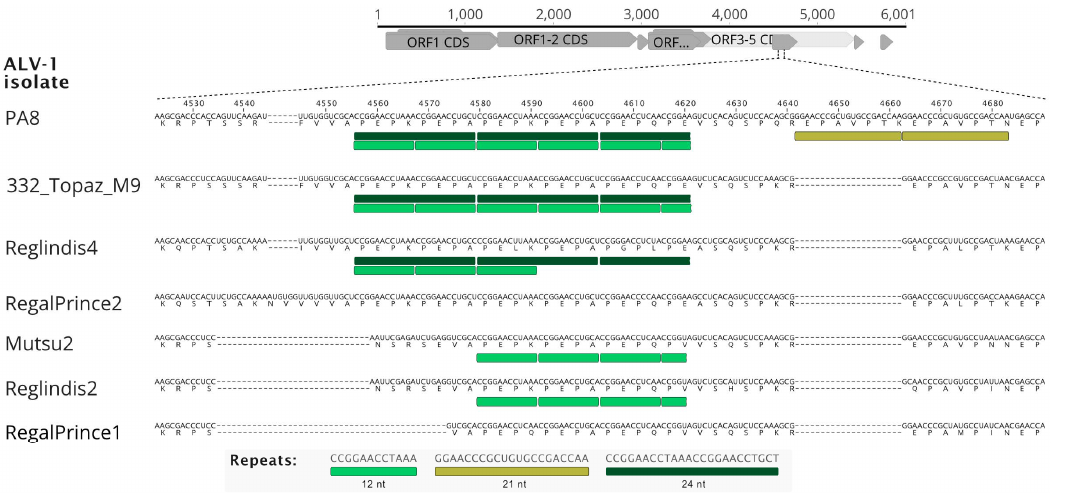
Figure 7. Multiple nucleotide alignment of the ORF5 region of the ALV-1 isolates with identified tandem repeats. The PA8 isolate was used as the reference. Deduced amino acid sequences are shown under respective nucleotide triplets. Gaps are shown as dashes. Consensus sequences of three kinds of tandem repeats are shown under the